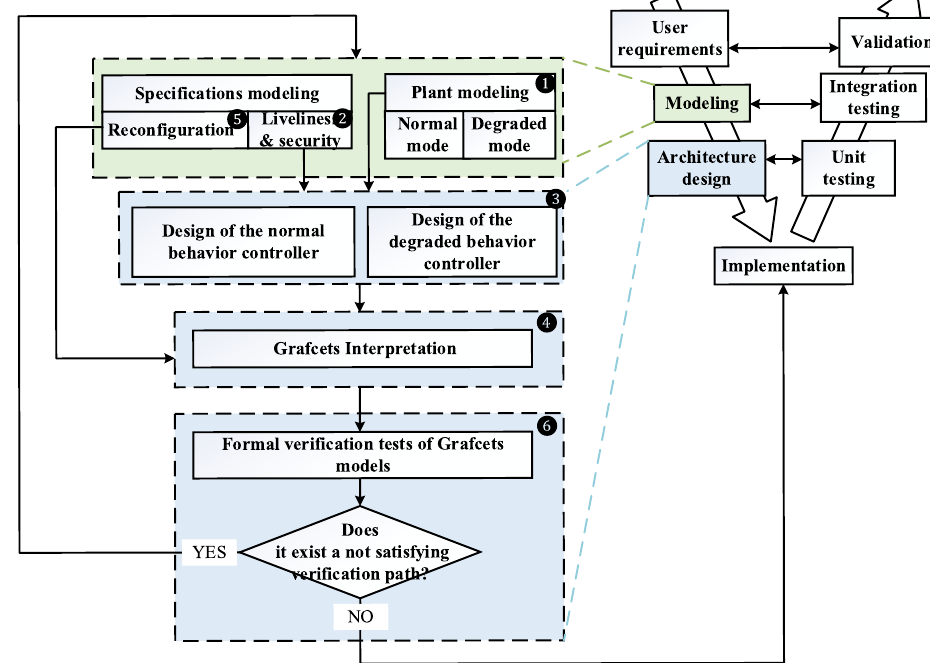
Figure 17. Formal architecture for a reconfigurable and fault-tolerant control synthesis adding a verification phase.